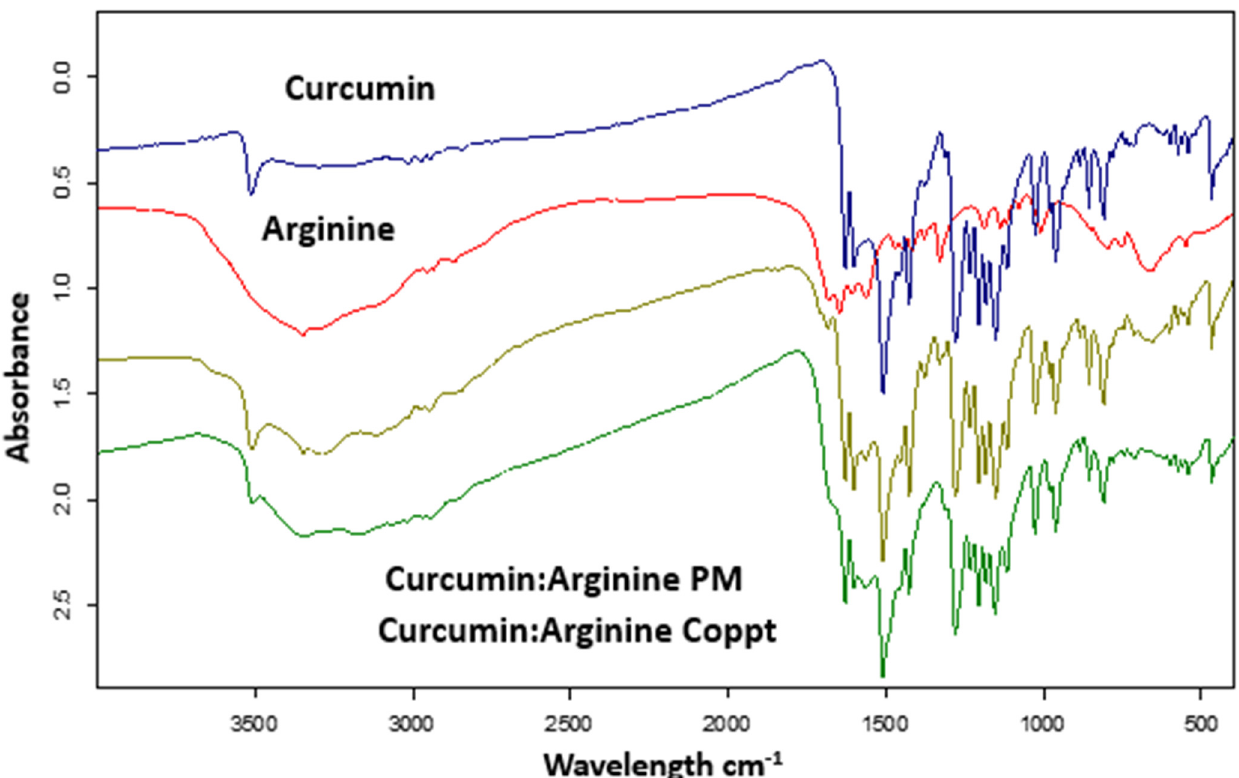
Figure 4. FTIR spectra of curcumin, curcumin-L-arginine physical mixture, and coprecipitated dis- persion.